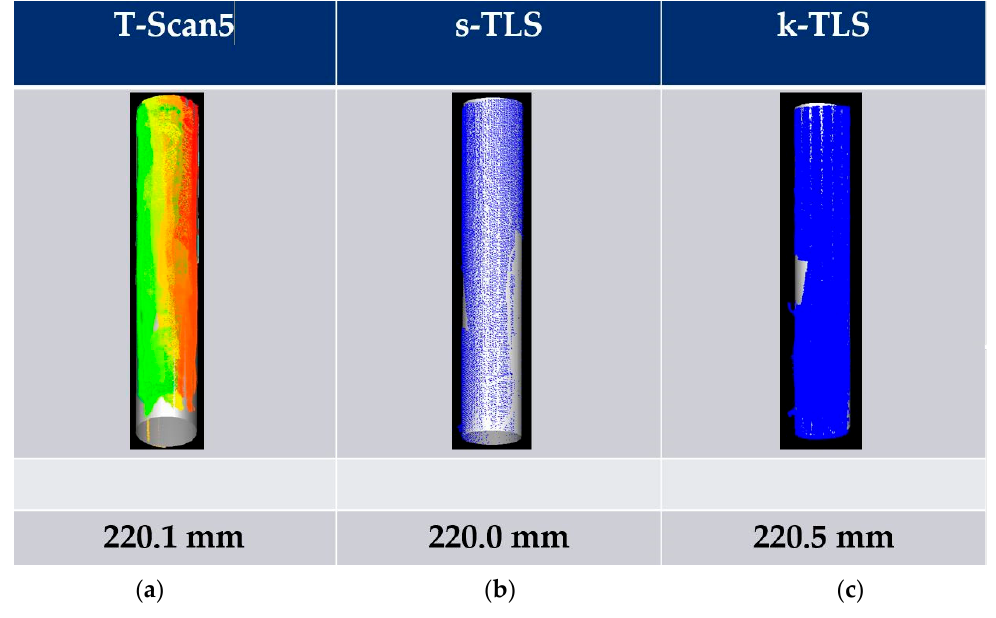
Figure 17. Diameter of a cylinder in [mm] derived from ( a ) T-Scan 5; ( b ) static TLS and ( c ) k-TLS measurements calculated with Leica Cyclone